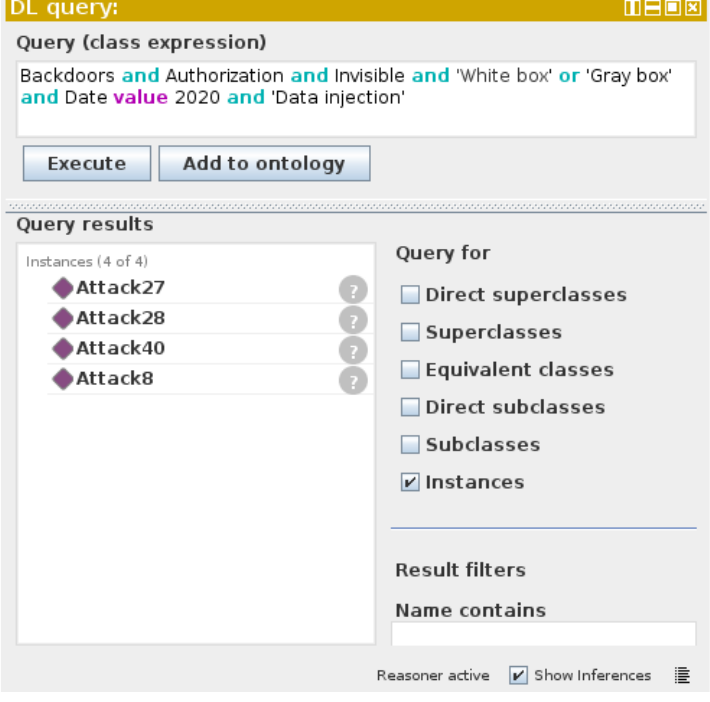
Figure 15. Using the DL Query and the HermiT reasoner to query the DNNPAO in